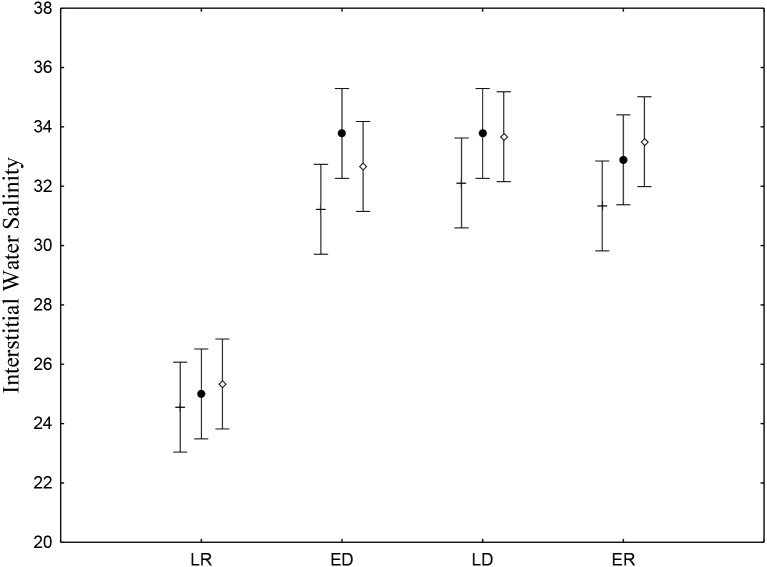
Salinity of sediments interstitial water.Average and standard deviations salinity of sediments interstitial water on the tidal plain of the Goiana estuary during different seasons (LR, Late Rainy; ED, Early Dry; LD, Late Dry, ER, Early Rainy) and habitats (+ = A; • = B; ◊ = C). Interaction between season vs. habitat: F(6,96) = 0.47035, p = 0.82878.